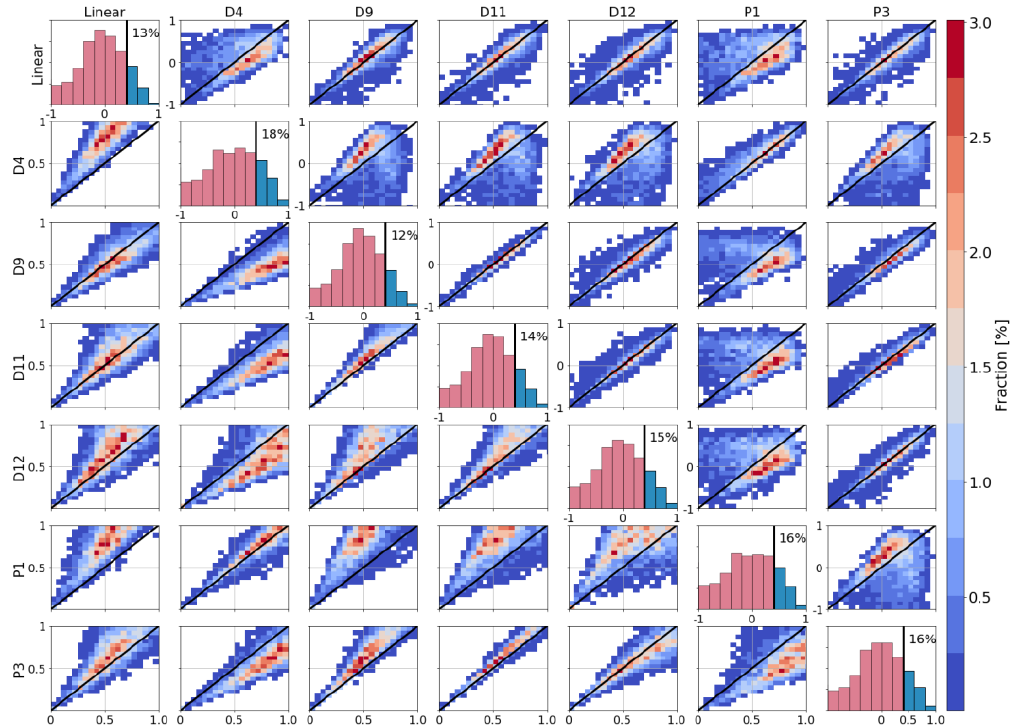
Figure 10. An event-based KGE comparison of the diagnostic and prognostic dominant scenarios. Each row compares a scenario against the others. The upper diagonal panels correspond to the KGE histogram of the scenarios. Over the diagonal the KGE histogram of each setup, a coloring in of the percentage of events with blue is visible, with a KGE of above 0.4. The lower diagonal compares the event-based mean-ratio error.